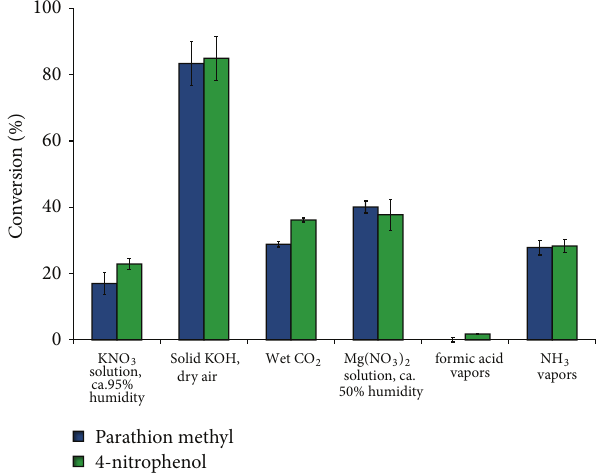
Figure 11: Degree of conversion of parathion methyl to 4- nitrophenol using the CeO 2 -based reactive sorbents stored under various conditions. Calculated from the 𝑞 ∞ values in Table